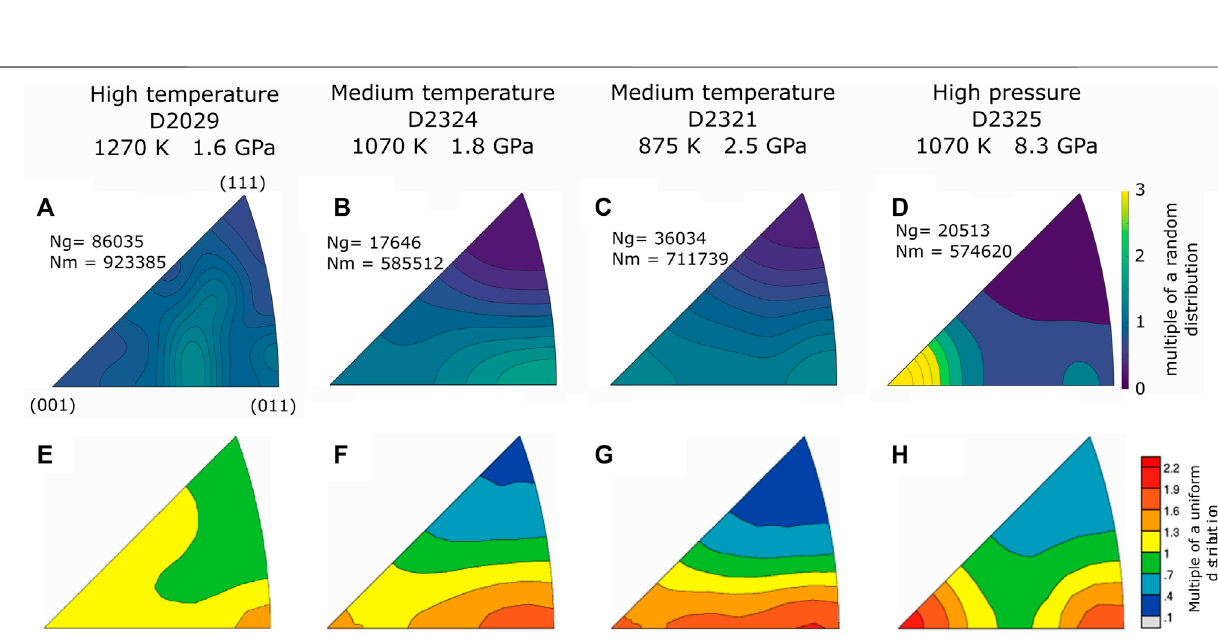
Frontiers in Earth Science |